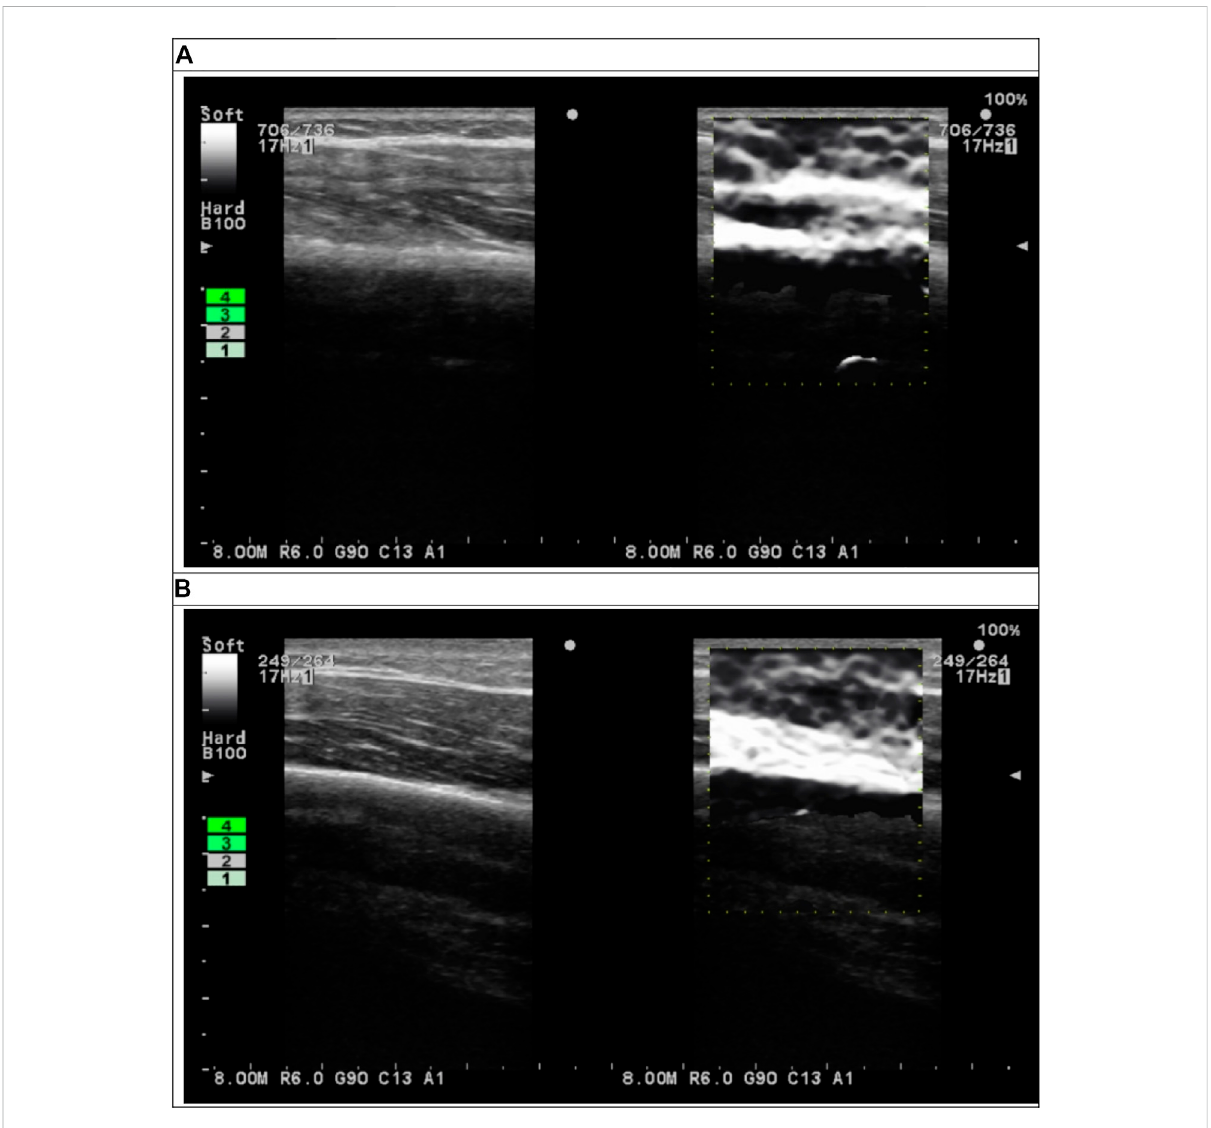
FIGURE 2 B-mode (left sub fi gures) and elastographic (right sub fi gures) ultrasound images of triceps (A) before and (B) after cupping